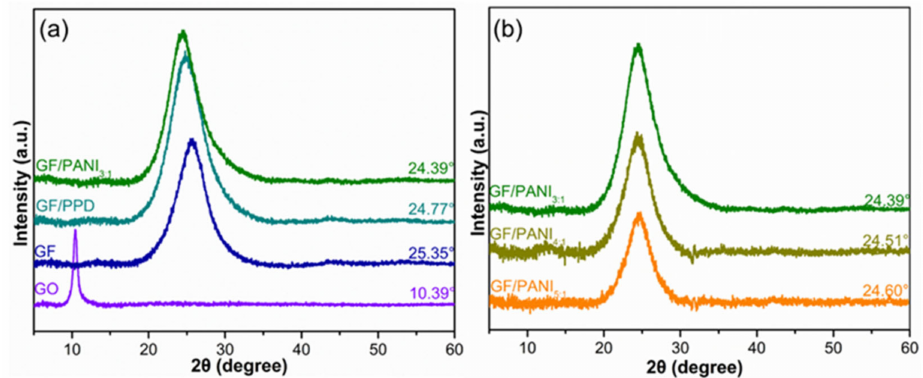
Figure 4. The XRD patterns of ( a ) GO, GF, GF/PPD, GF/PANI 3:1 and ( b ) GF/PANI 5:1 , GF/PANI 4:1 , GF/PANI 3:1 filler with different amount of PANI.